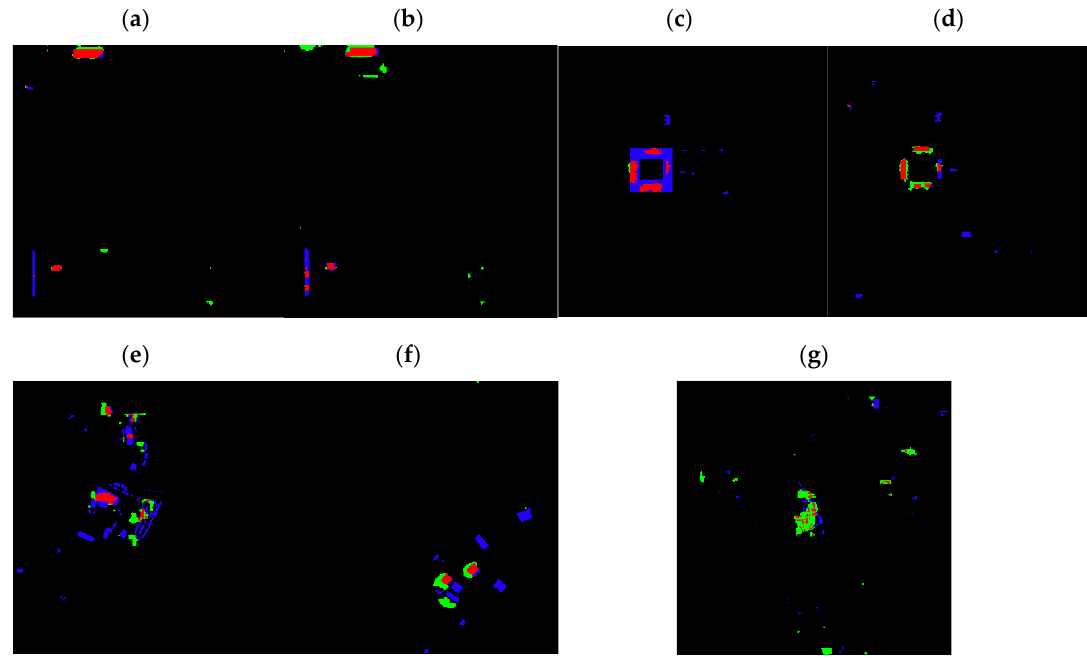
Figure 17. Comparison of the proposed model’s result and the ground truth of ( a ) the first test area of Bangkok SAR pair 27 November 2008/15 January 2010, ( b ) the first test area of Bangkok SAR pair 12 January 2009/21 November 2009, ( c ) the second test area of Bangkok SAR pair 27 November 2008/15 January 2010, ( d ) the second test area of Bangkok SAR pair 12 January 2009/21 November 2009, ( e ) the first test area of Xiamen SAR pair, ( f ) the second test area of Xiamen SAR pair, ( g ) the test area of Hanoi SAR pair ((red) true positive area, (green) false positive area, (blue) false negative area) (the resolution of each image is 6 km × 6 km).